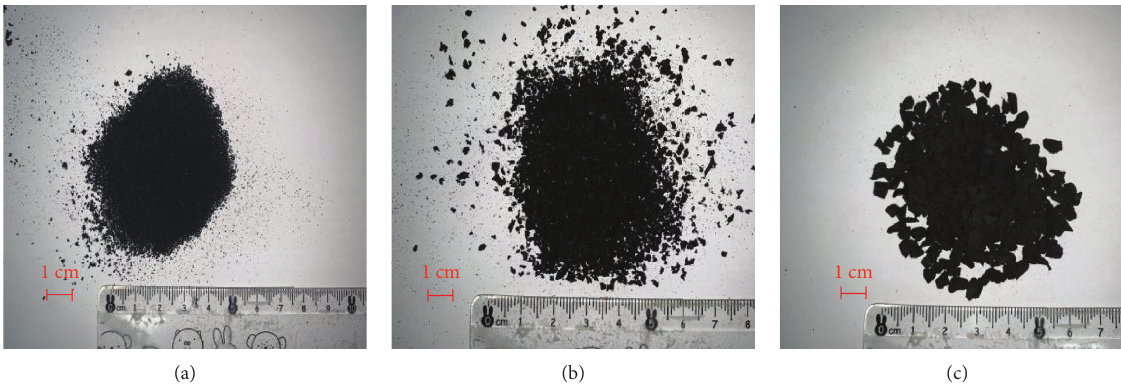
Figure 2: The waste tires are shredded in different sizes. (a) < 0.05mm. (b) 0.5–2mm. (c) 2–4 mm.